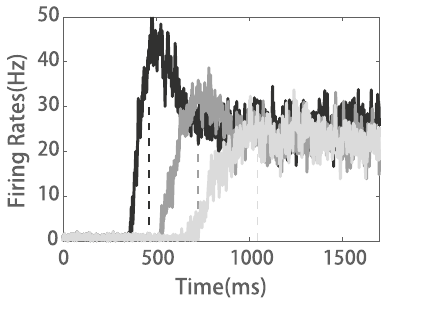
(b) Neural activities aligned with the decision moment. The horizontal axis shows the time to the decision moment.